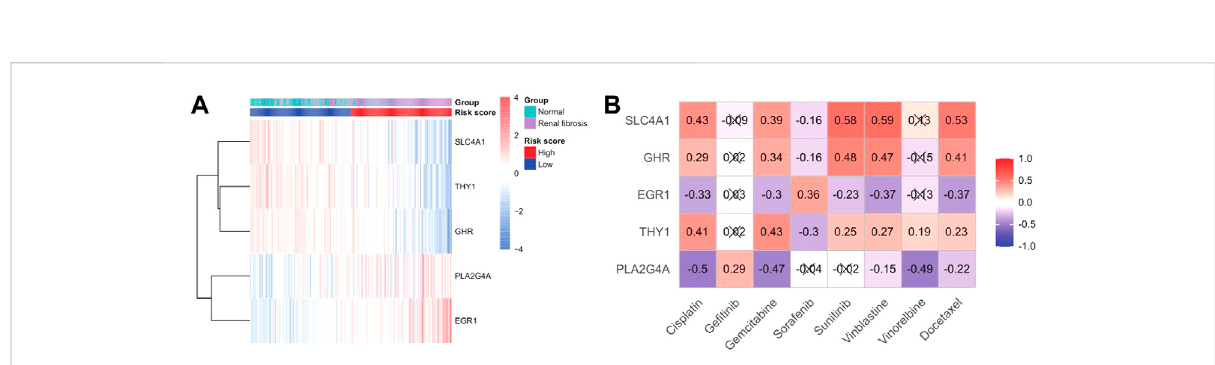
FIGURE 9 Sensitivity analysis of gene and drug therapy. (A) Heatmap of the expression of model genes in disease and risk groups. (B) Heatmap of model gene – drug